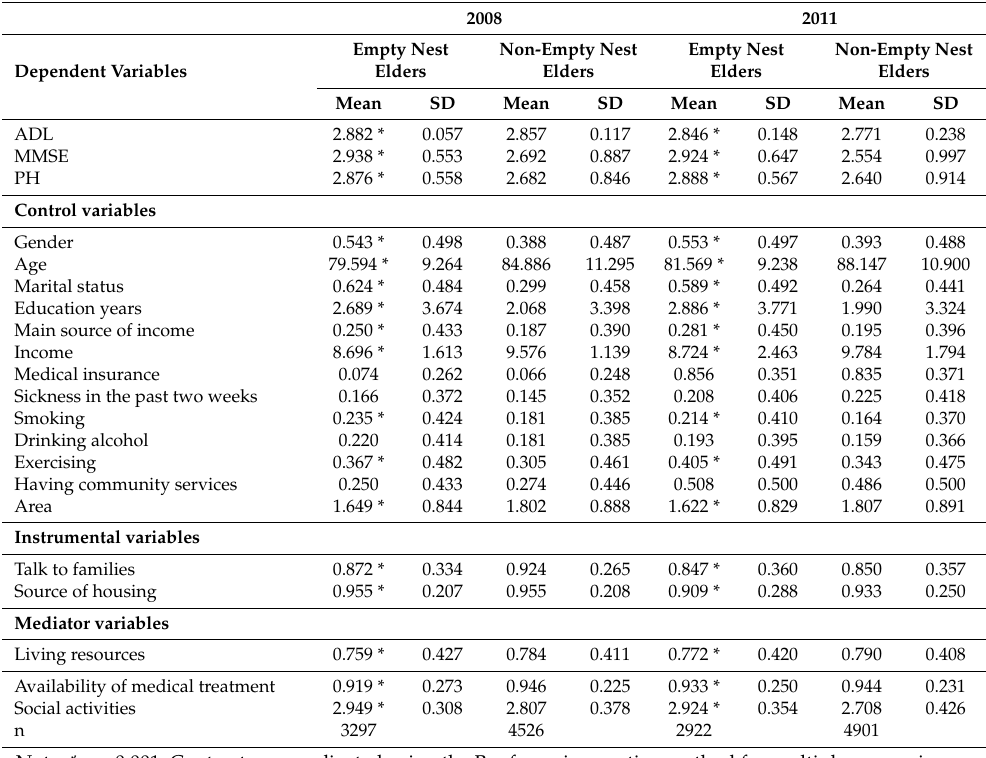
Table 2. Sample description and analysis of variance, CLHLS